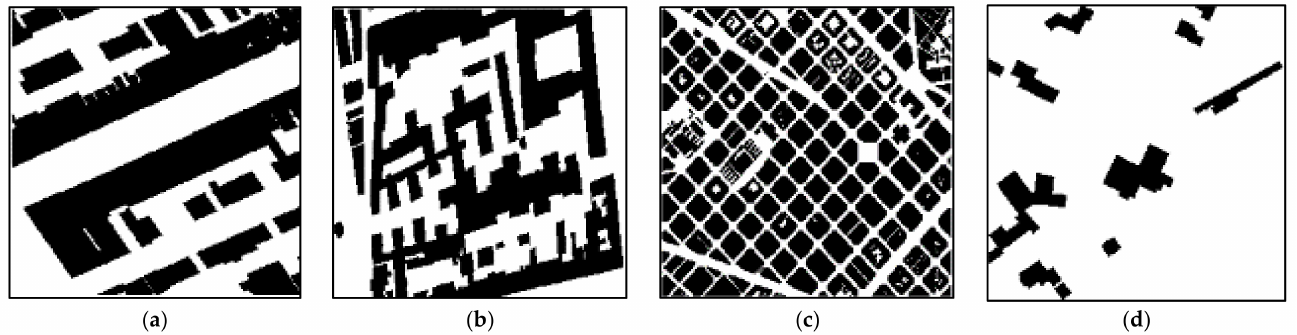
Figure 3. Random samples from the four groups ( a – d ) depict clusters from datasets of N.Y.C., Paris, Barcelona, and Germany, respectively. Black pixels represent the location of footprints, and white pixels represent background.